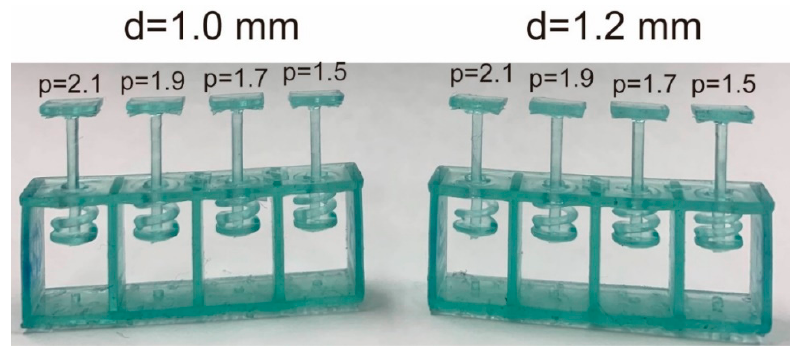
Figure 5. Test pieces of 3D printed coiled springs. The square plate above the prongs is the support plate used to measure the spring constant.